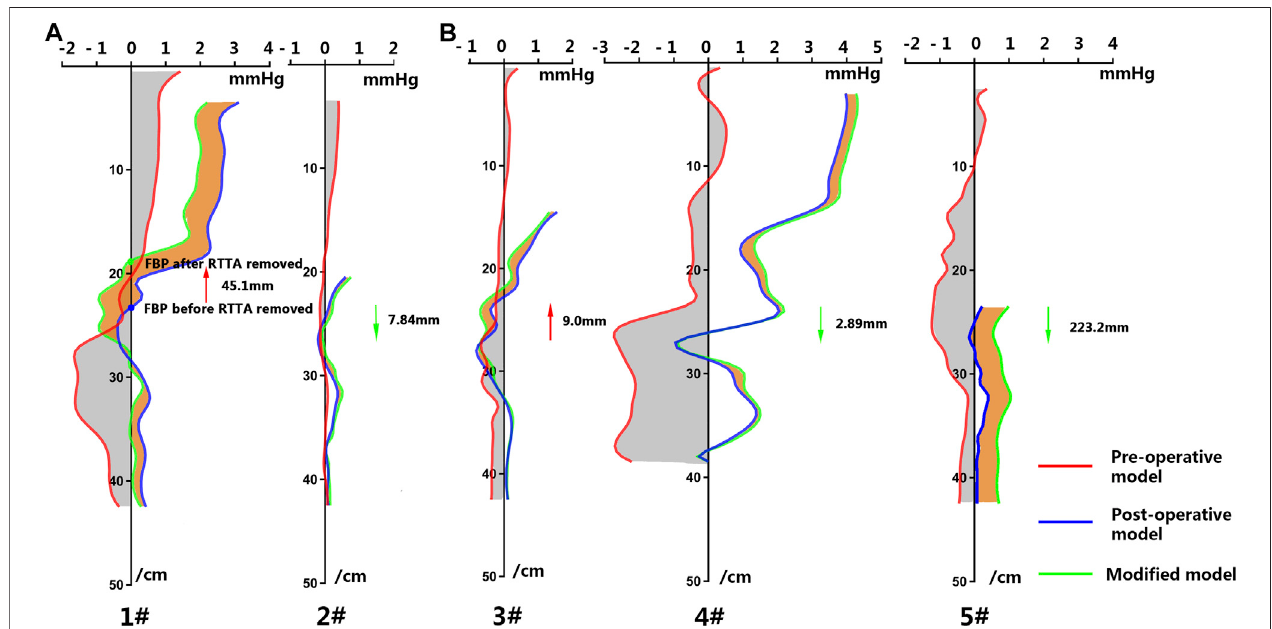
FIGURE 3 | Luminal pressure difference (LPD) along the central line of the true lumen for the patients in group A (A) and group B (B) .